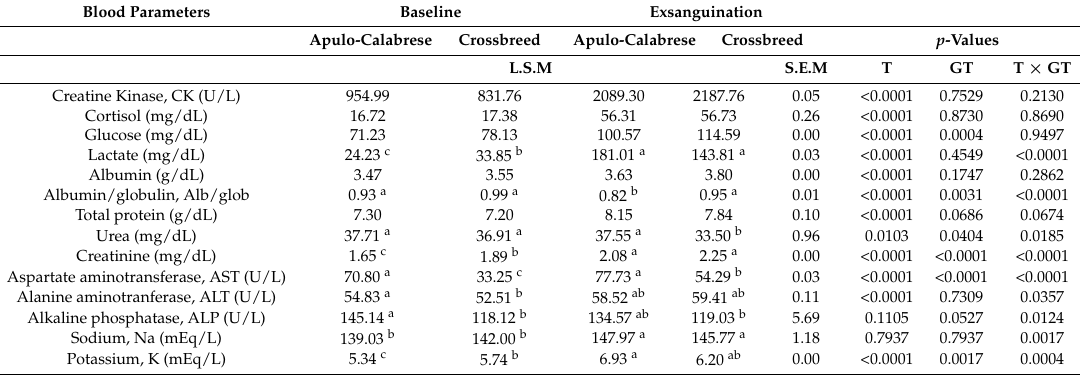
Table 2. Effects of sampling time (T), genetic type (GT), and their interaction (T × GT) on least square means (L.S.M) and standard error of means (S.E.M.) of blood parameters of Apulo-Calabrese and crossbreed pigs on farm (baseline) and at